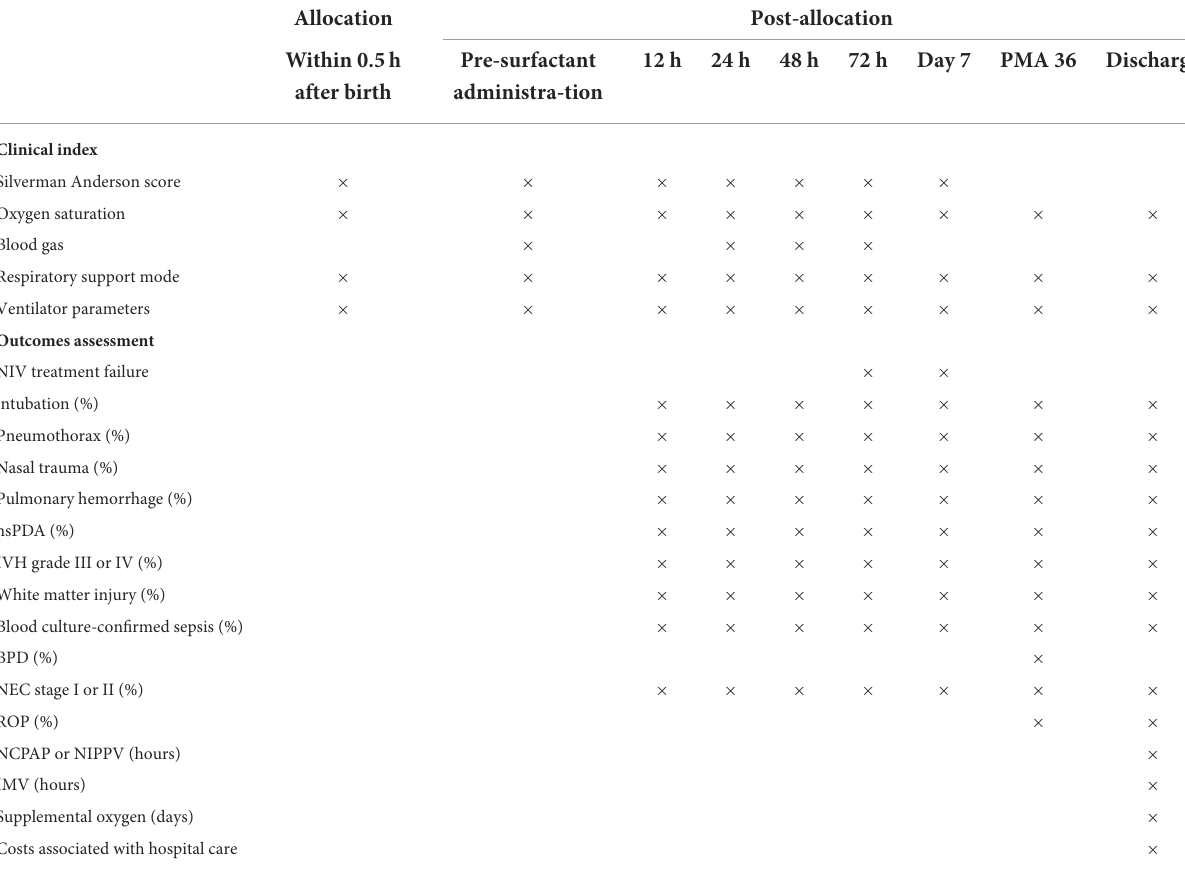
TABLE 1 List of measures and assessment points.